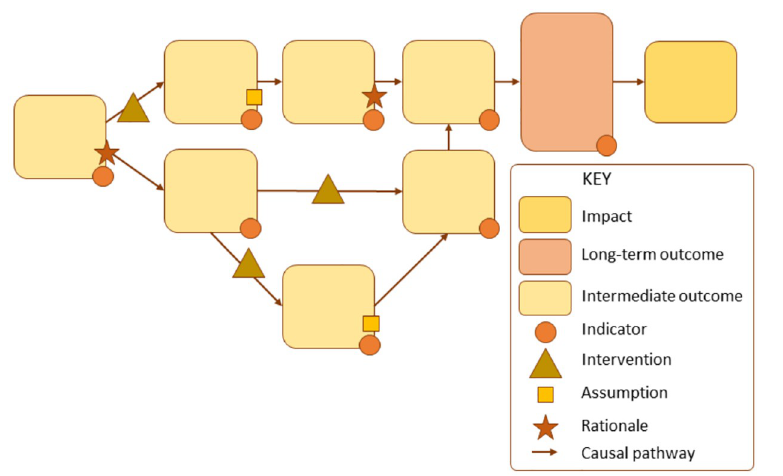
Fig 2. Example of theory of change for an intervention. Source: Sapkota et al., 2019, p.6 [14].